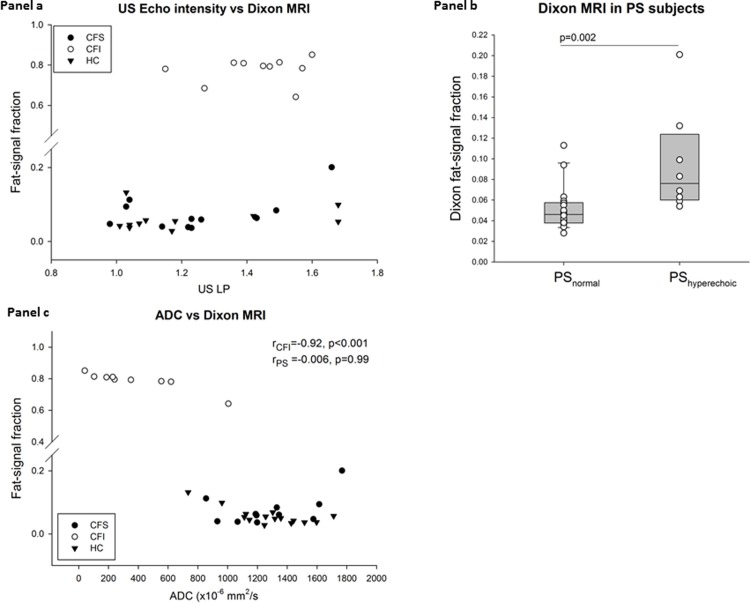
Panel a displays poor correlations in a scatterplot between the US liver/pancreas echo-intensity ratio and the MRI fat-signal fraction (FSF).There is a marked difference in the FSF between the pancreatic sufficient (CFS and HCs) and pancreatic insufficient (CFI) groups. Panel b displays the difference of fat-signal fraction between the subjects with a hyperechoic pancreas and the subjects with a normal pancreas in the pancreatic sufficient (PS) subjects (i.e. CFS and HC). Panel c displays almost perfect correlation between the pancreatic MRI-Dixon fat-signal fraction and the pancreatic ADC value in CFI patients and lack of correlation in the in the pancreatic sufficient groups. ADC: apparent diffusion coefficient, CFI: Pancreas insufficient cystic fibrosis, CFS: Pancreas sufficient cystic fibrosis, HC: Healthy control.